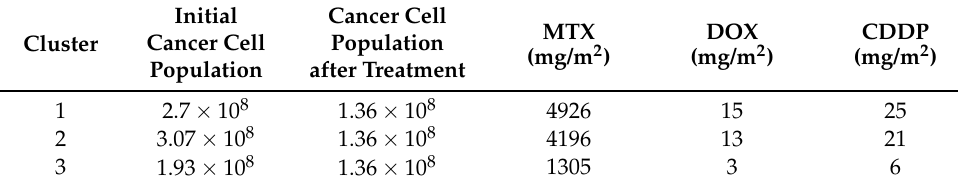
Table 6. Optimal MAP dosages for small